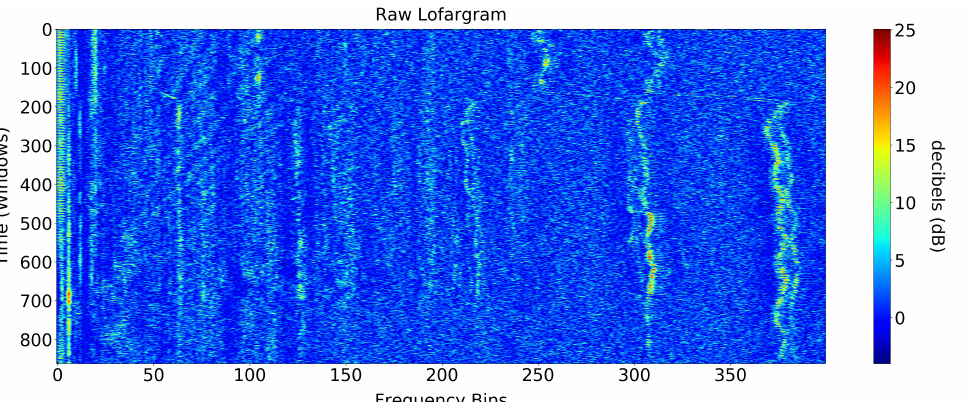
Figure 2. The LOFARGRAM. This waterfall display shows the frequency information of a given target across